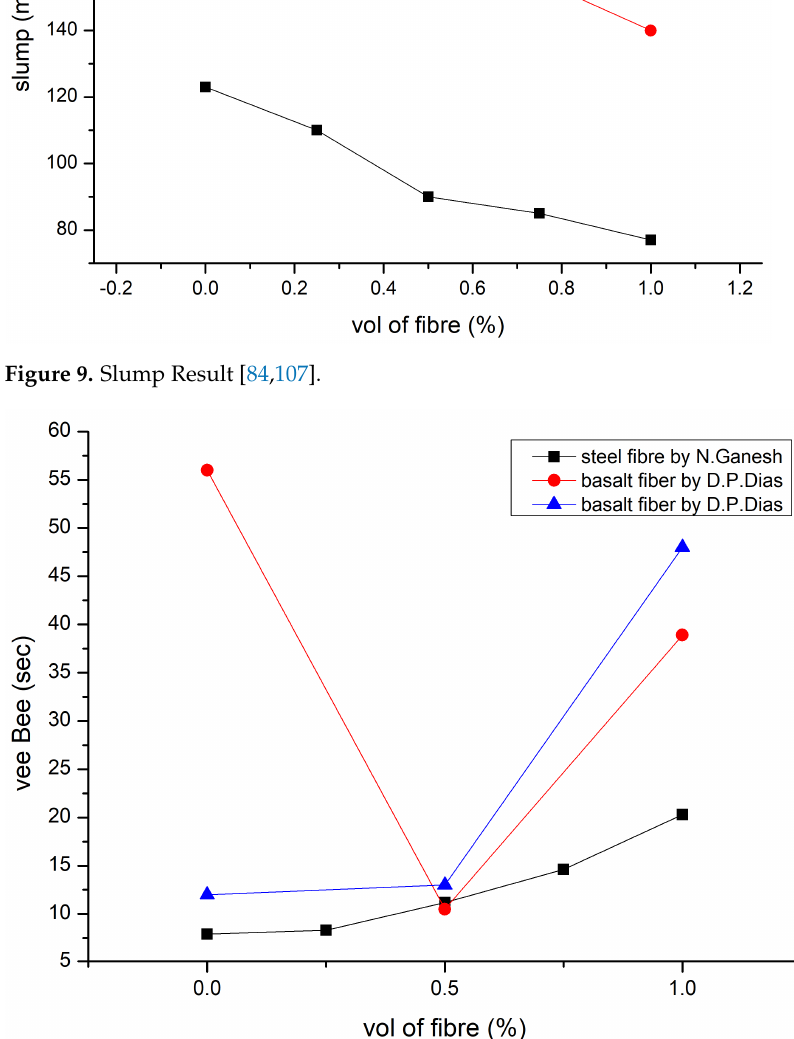
Figure 10. Vee Bee Results [92,112].